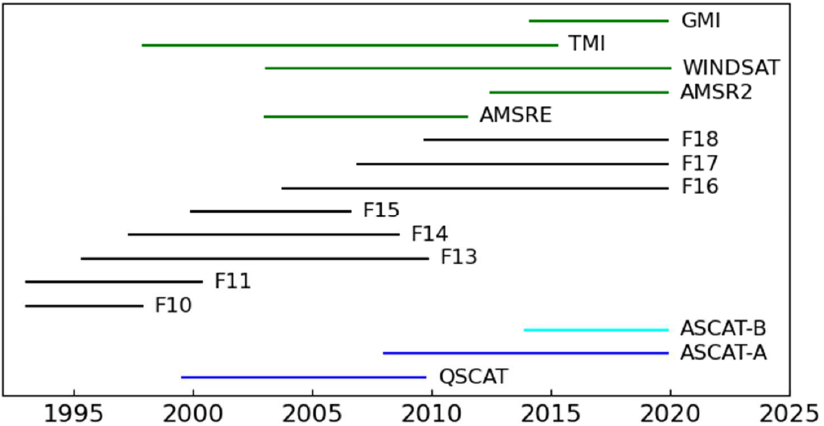
Figure 1. Times that each satellite contributes to CCMP. Scatterometers are shown in blue, and radiometers are shown in black (SSM/I series,) and green. Those shown in green include the lower frequency 11 GHz channel. ASCAT-B is shown in light blue because it is withheld from CCMP and is instead used as a source of validation